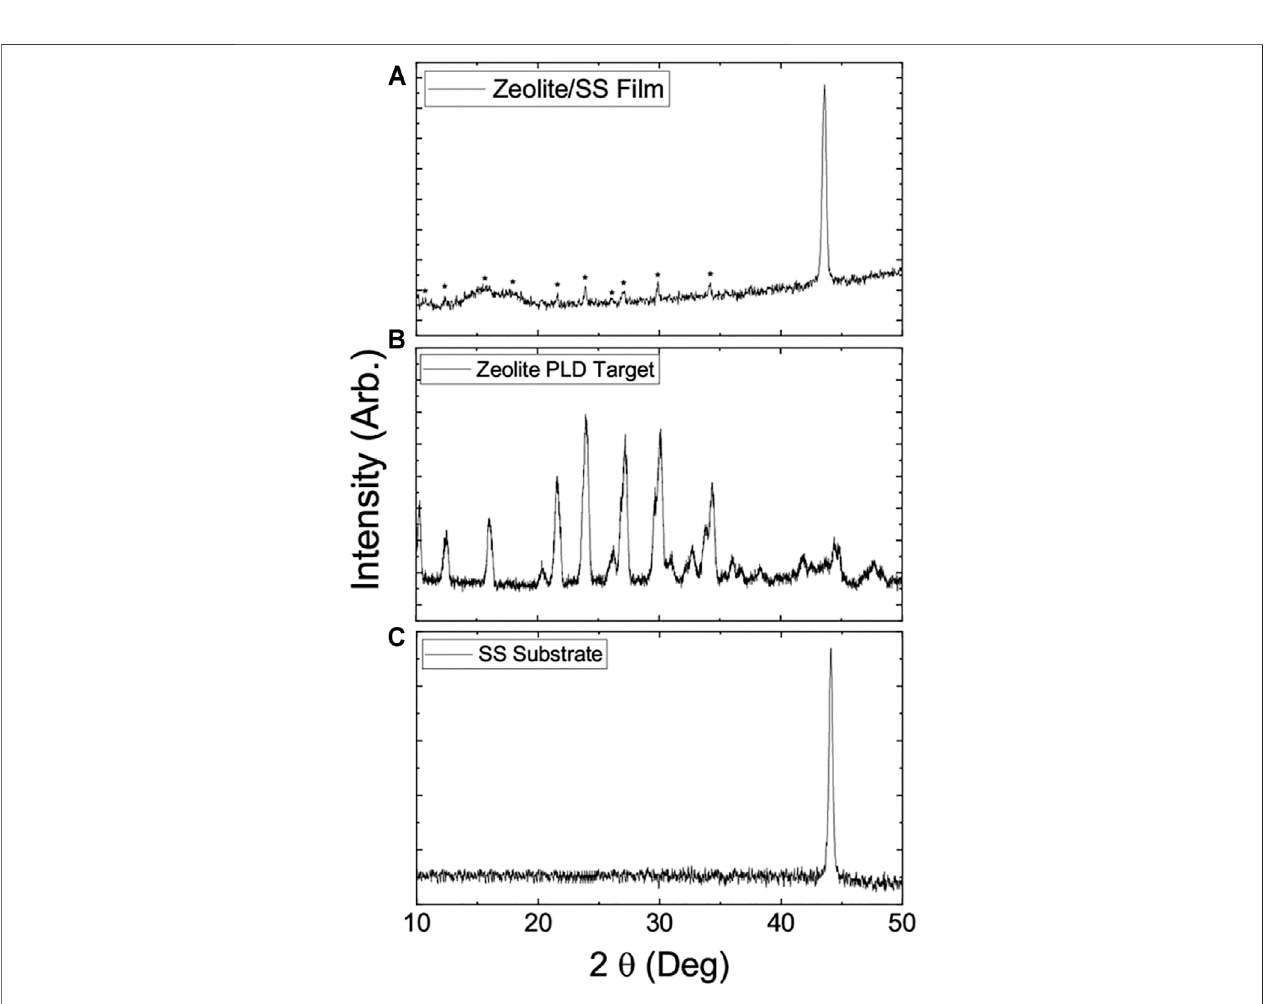
Frontiers in Chemistry |